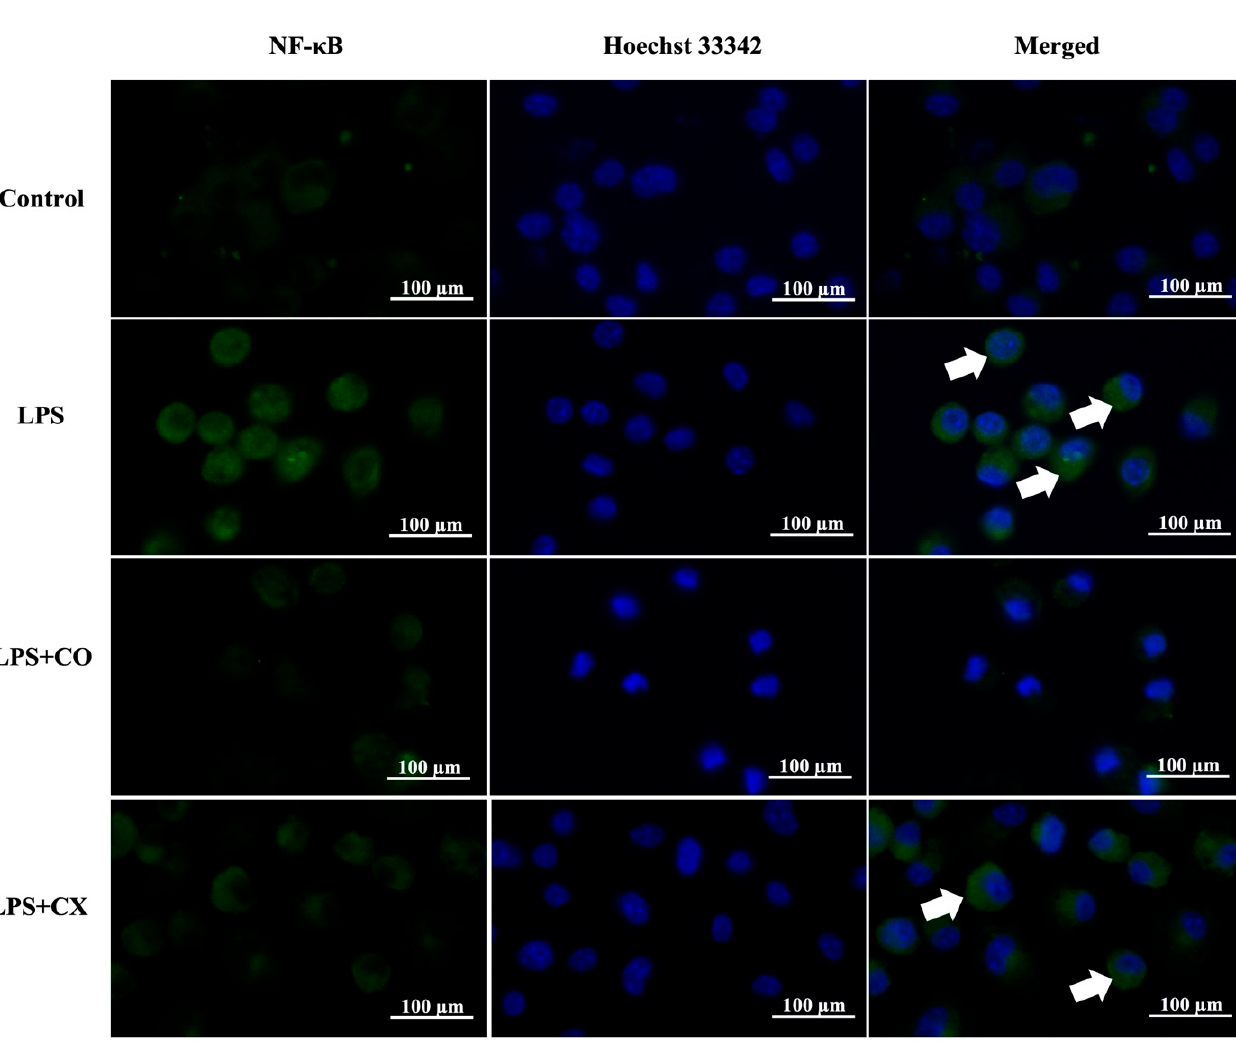
Figure 4. Effects of CO on NF- κ B p65 nuclear activation. Cells were treated with 2% CO or 10 µ M CX in the presence or absence of LPS for 24 h. Cells were stained with NF- κ B p65 antibodies (green) and Hoechst 33342 (blue). Nuclear activation of NF- κ B p65 (white arrow) was assessed using a fluorescent microscope.